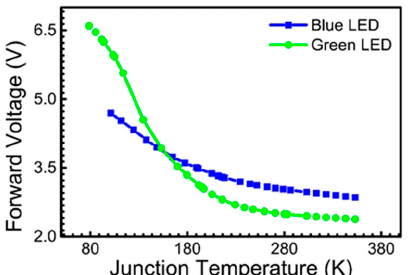
Figure 2. Relationship of forward voltage ( V F ) and junction temperature ( T j ) for blue and green LEDs with the sensor unit.